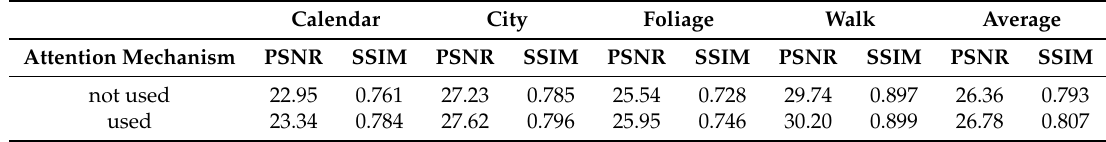
Table 6. The influence of the attention mechanism for 4 × VSR.